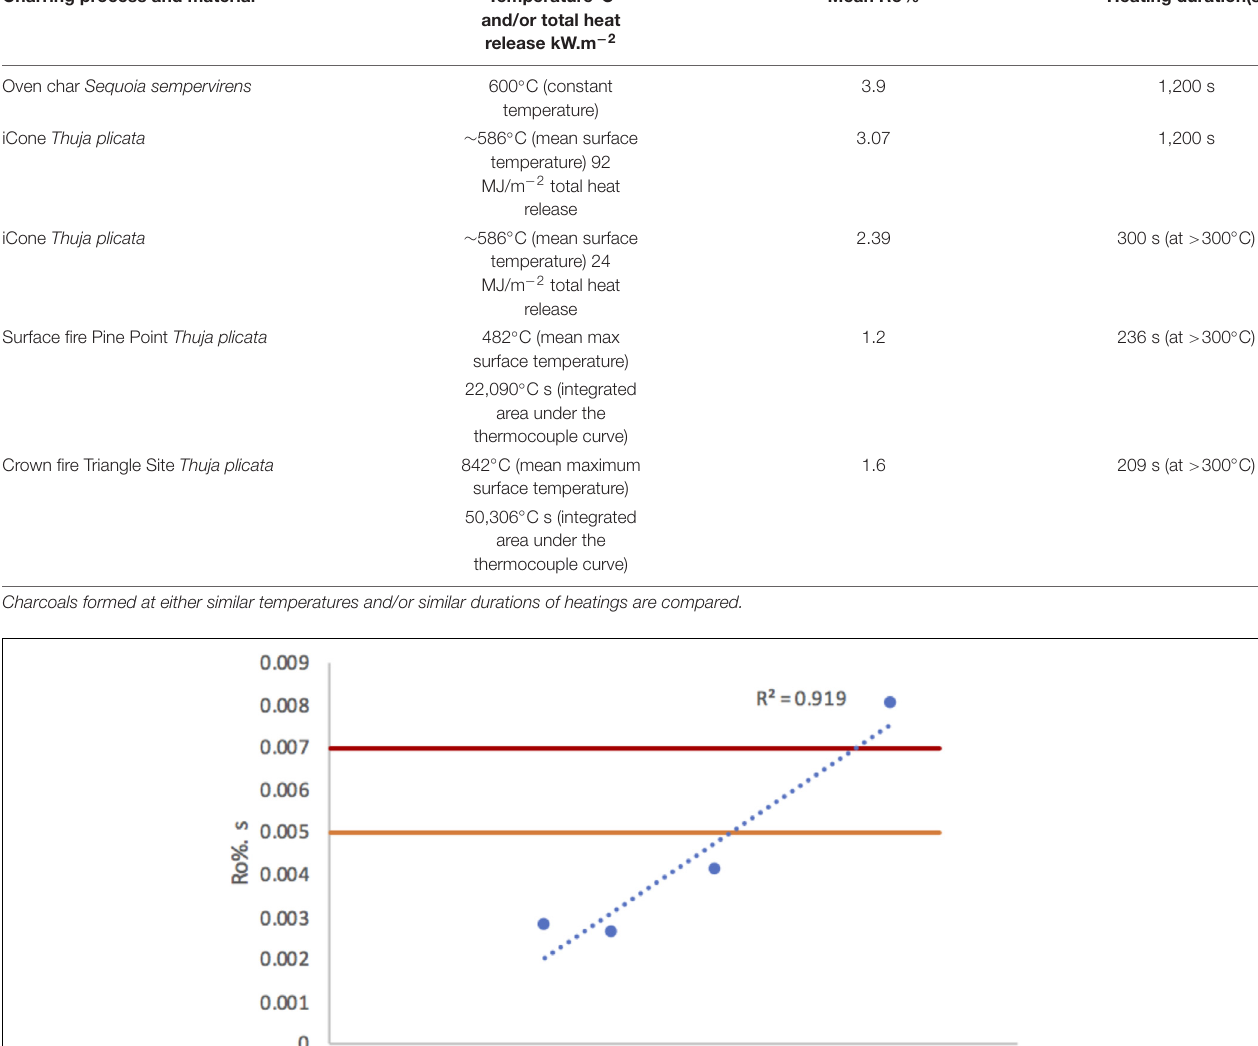
reflective properties, that variations in the Ro% and THR relationship should be considered within species and not between